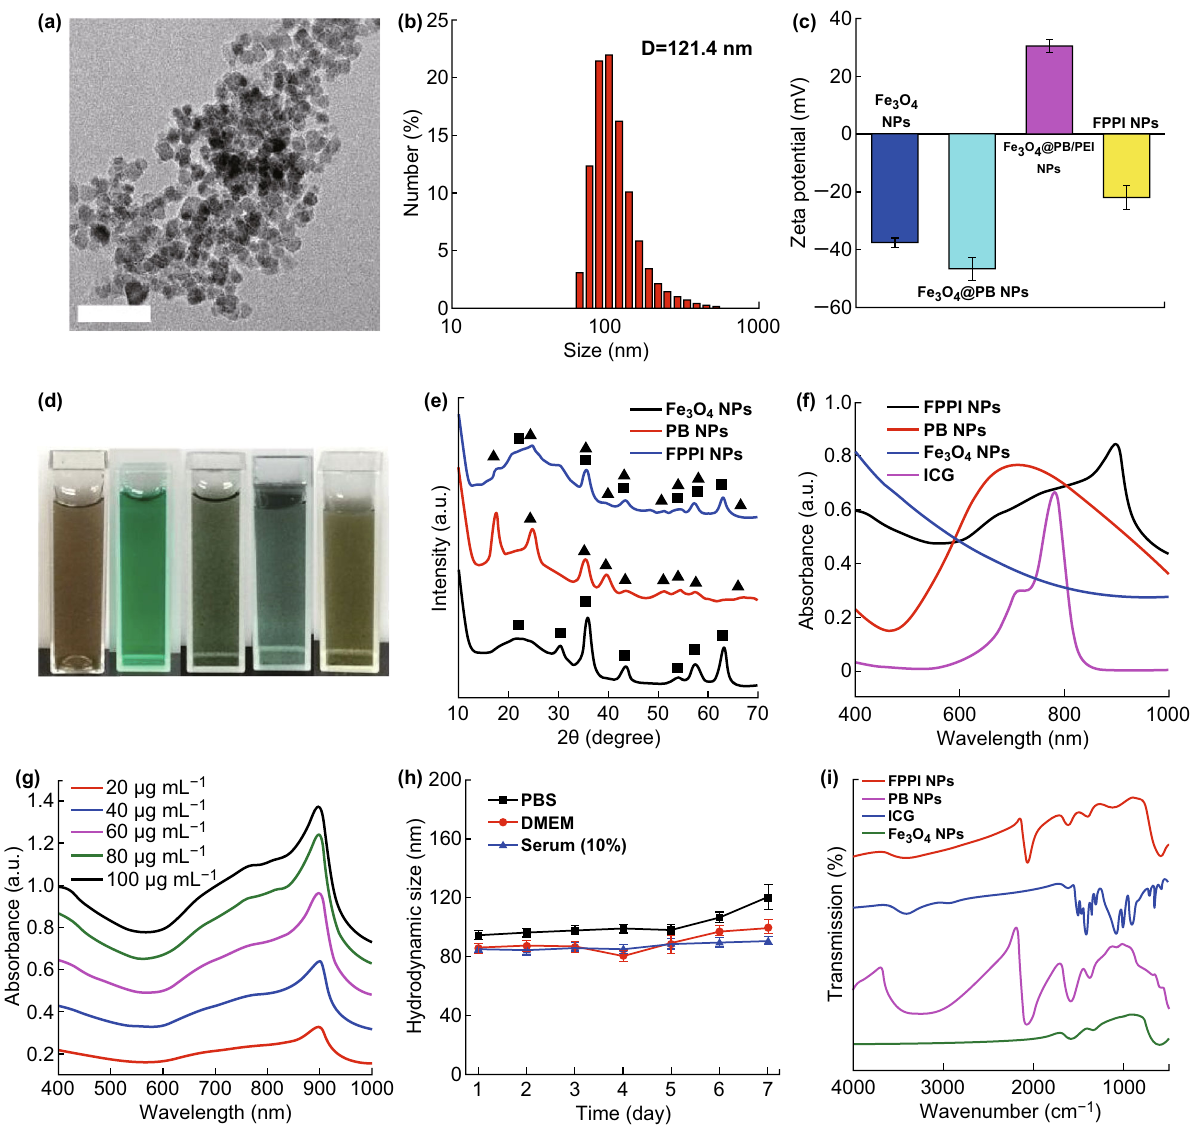
Fig. 2 Characterizations of physicochemical properties: a high-resolution TEM image of FPPI NPs obtained by electrostatically conjugating ICG onto the surface of magnetic PB NPs (scale bar: 50 nm); b hydrodynamic size distribution of FPPI NPs in aqueous suspension measured by the DLS method; c zeta potentials of the intermediate and final products; d photographs of Fe 3 O 4 NPs, free ICG, Fe 3 O 4 @PB NPs, Fe 3 O 4 @PB/ PEI NPs, and FPPI NPs (from left to right) dispersed in aqueous condition; e XRD patterns of Fe 3 O 4 NPs, PB NPs, and FPPI NPs; f Vis–NIR absorbance spectra of Fe 3 O 4 NPs, PB NPs, ICG, and FPPI NPs dispersed in aqueous solution; g Vis–NIR absorbance spectra of FPPI NP dispersions with different concentrations; h hydrodynamic size variation of FPPI NPs dispersed in 1 9 PBS, DMEM, or 10% FBS over 7